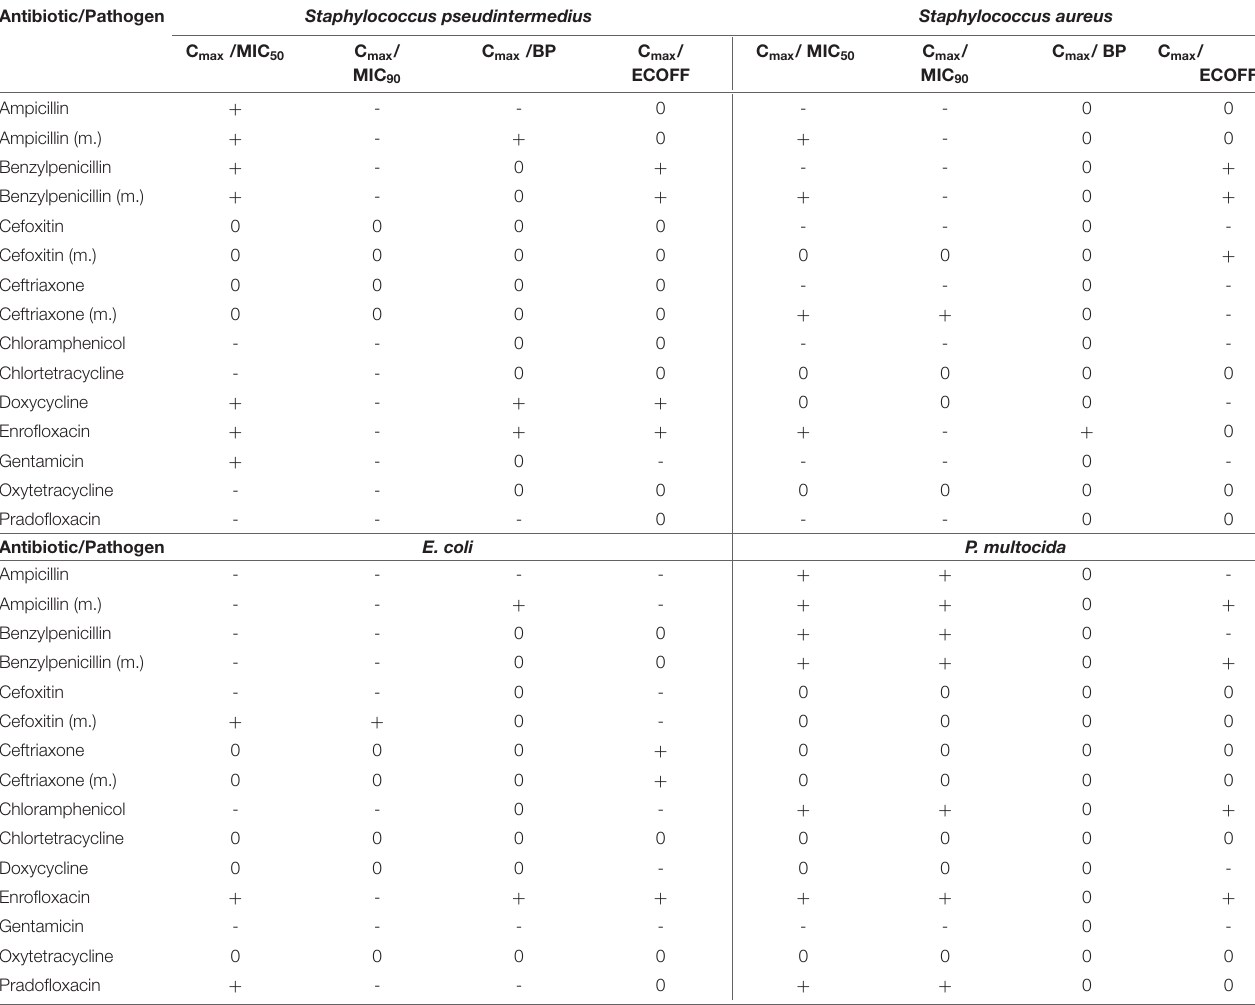
TABLE 6 | PK-PD-Target attainment for various antibiotics and different pathogens in dogs. Antibiotic/Pathogen